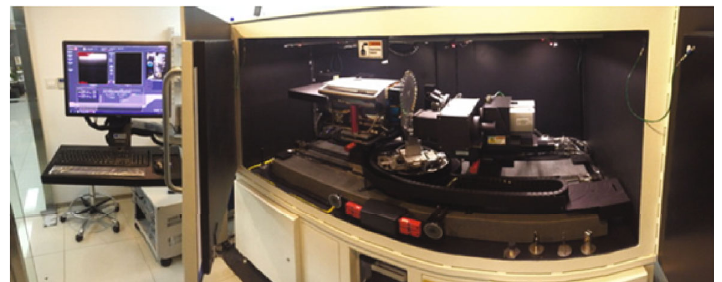
Figure 2: Zeiss Xradia CT-520 Versa.